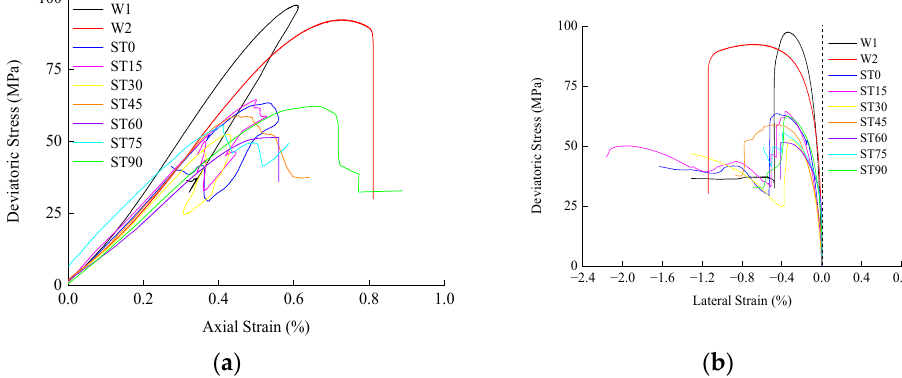
Figure 5. Stress-strain curves of intact and T-shaped sandstone specimens under hydro-mechanical coupling: ( a ) Axial strain-deviatoric stress relationship, ( b ) Lateral strain-deviatoric stress relationship. Table 3. Summary of sandstone progressive failure thresholds under hydro-mechanical coupling. Specimen No.